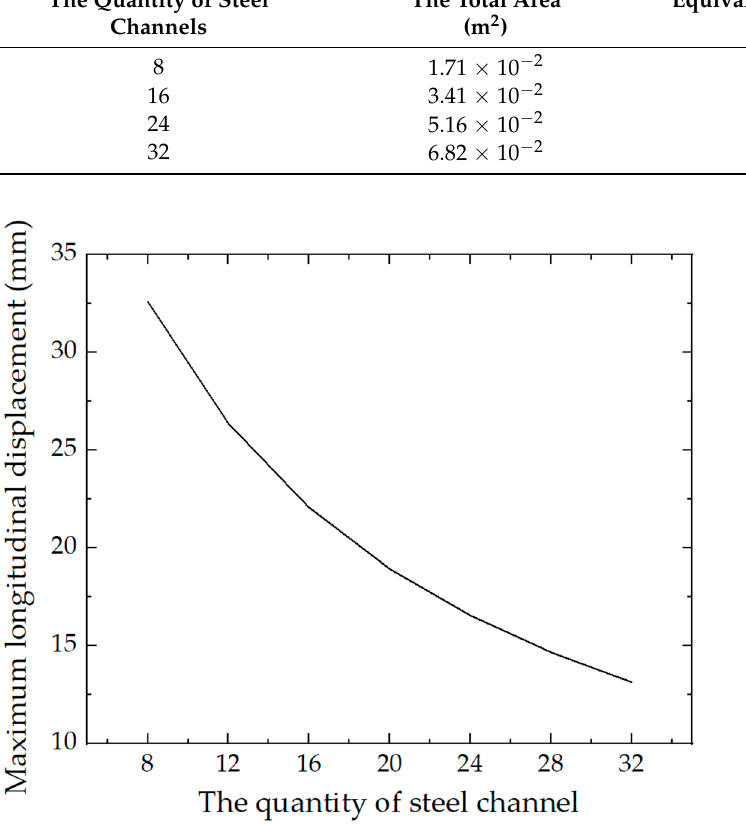
Figure 15. Maximum longitudinal displacement under different quantities.